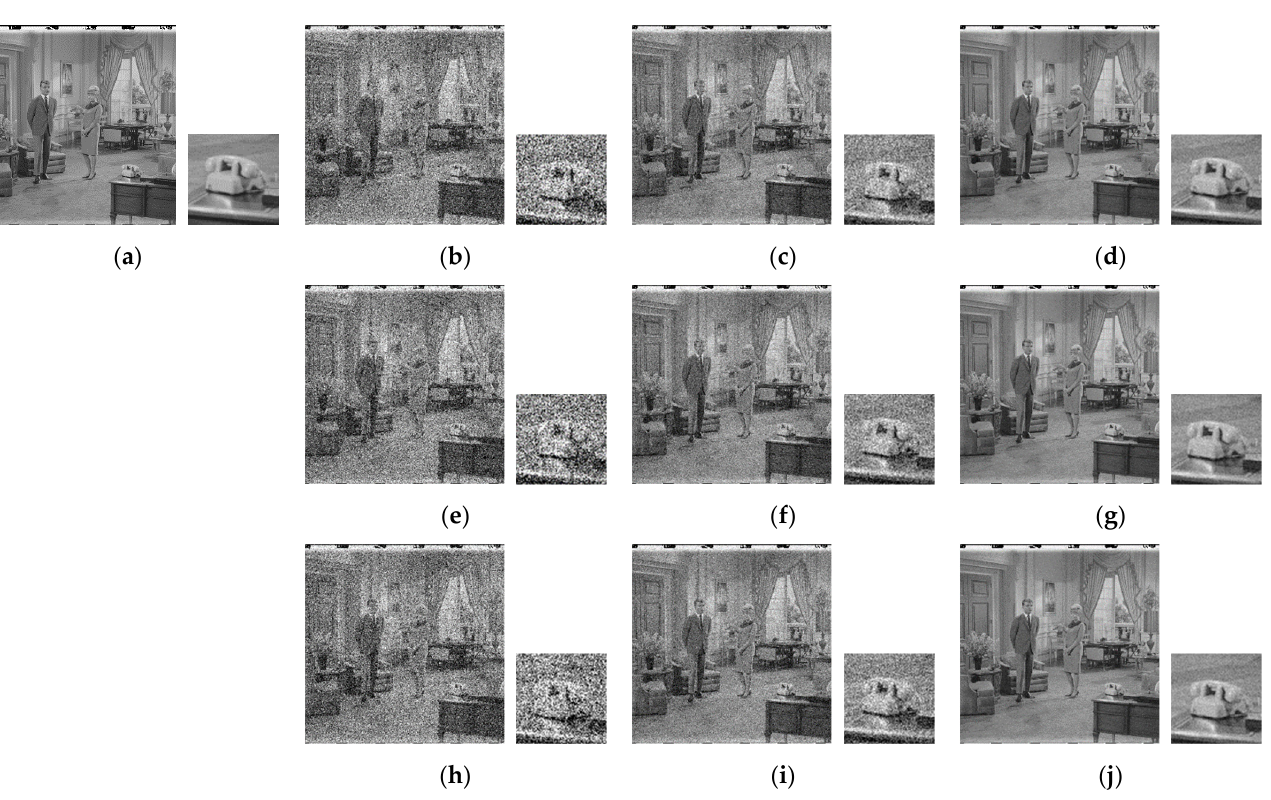
Figure 4. Robustness analysis of perceptual encryption (PE) methods against Gaussian noise (GN). ( a ) is original image without noise. Recovered images from noisy cipher images by conventional PE method ( b – d ), proposed PE method (4 × 4) ( e – g ) and proposed PE method (2 × 2) ( h – j ). The GN variance is { 0.05, 0.0125, 0.001 } in Column 2–4, respectively. The telephone set is zoomed in every image and is shown beside them. Table 4. Robustness analysis of perceptual encryption algorithms against salt and pepper noise and Gaussian noise. The image quality is in terms of MS-SSIM (dB). Proposed Noise Type Conventional 4 × 4 2 × 2